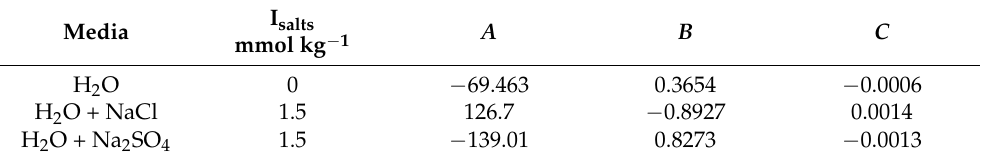
Figure 3. Enthalpy change vs. entropy change plot for the aggregation of CPC + 0.1% ( w / v ) PVP mixed system in water.